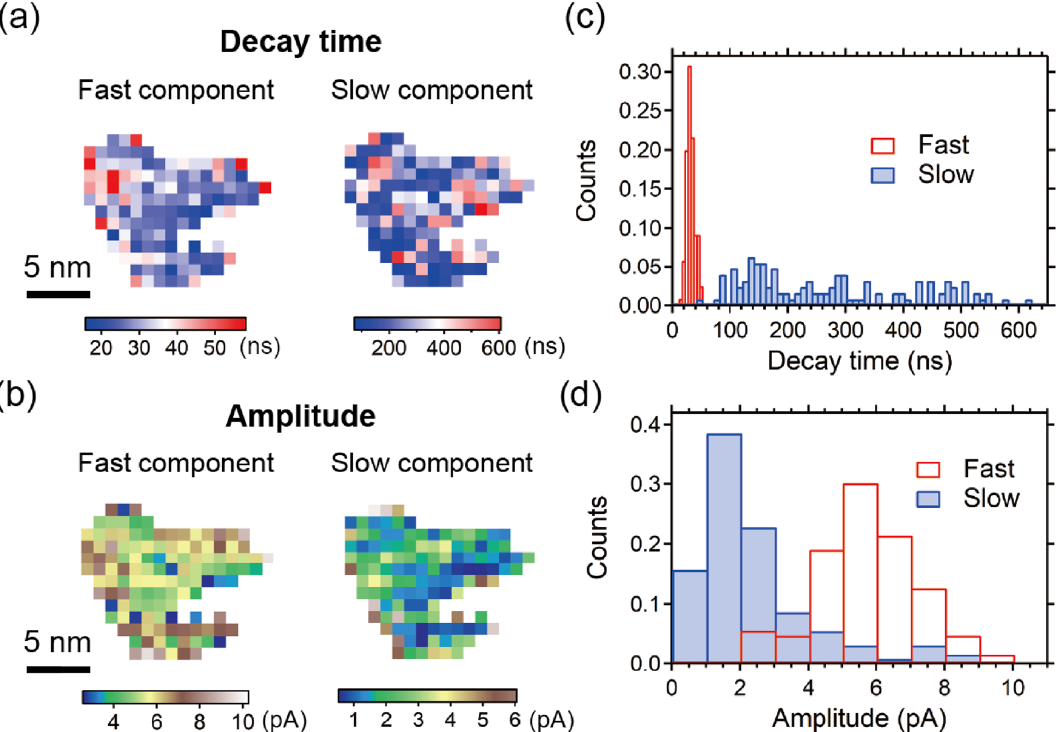
Figure 8. ( a ) Decay time map of the fast and slow components in the bump structure in Fig. 7a. The decay time at each location is estimated by fitting the spectrum with double exponential curves. (Left) Fast component. (Right) Slow component. ( b ) Amplitude map of the double exponential curves. (Left) Fast component. (Right) Slow component. ( c ) Histogram of the decay time of the fast and slow components in ( a ). ( d ) Histogram of the amplitude of the fast and slow components in ( b ). The numbers of counts are normalized in ( c ) and ( d